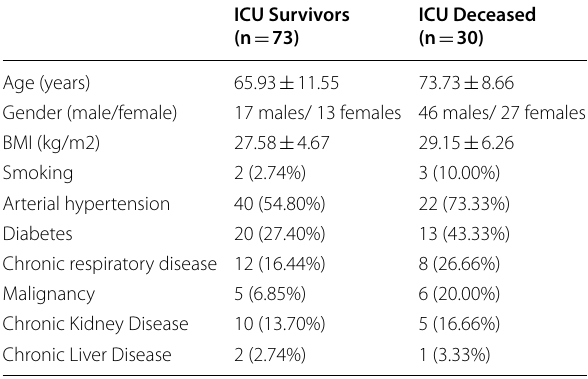
Table 1. Baseline demographics and medical history. Data are pre- sented as mean standard deviation or as number ±